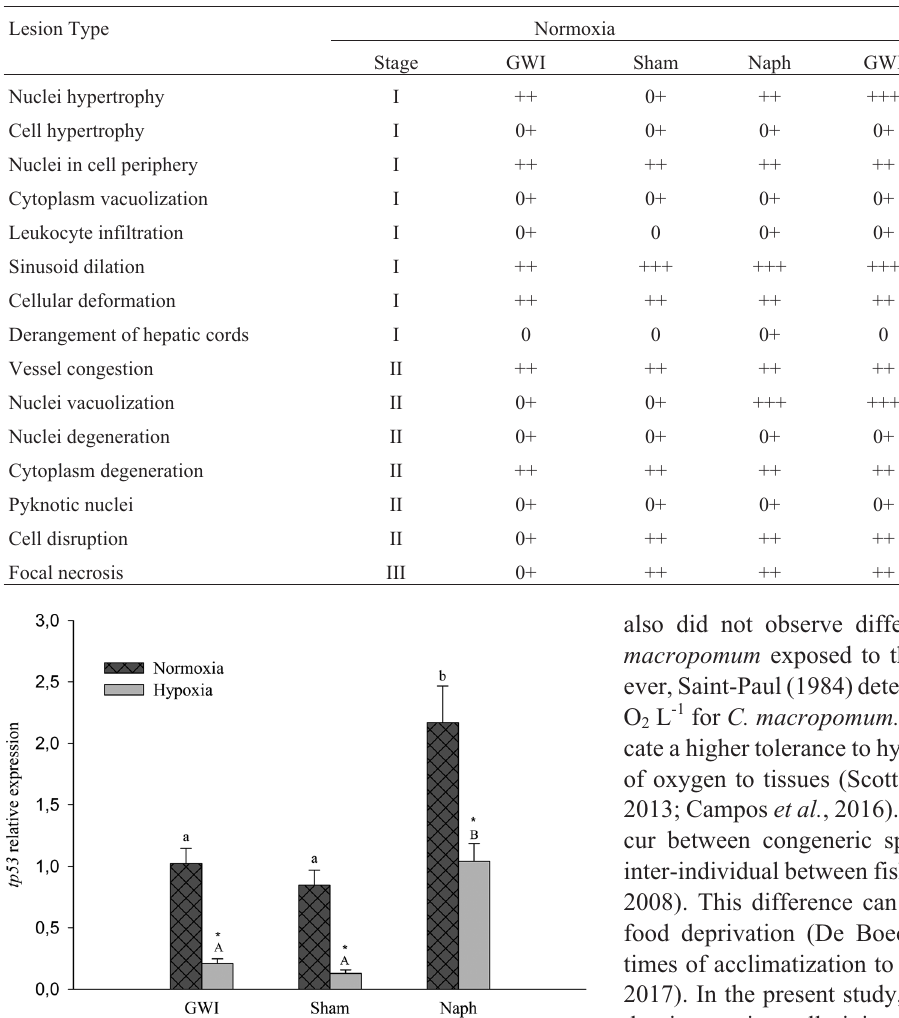
Table 2 - Qualitative distribution of histopathological damage and occurrence intensity (0 absent, 0+ rarely present, + low frequency, ++ frequent and +++ high frequency) on the liver of C. macropomum in the groups without injection (GWI), with corn oil injection (Sham) and naphthalene injection (Naph) after 96 h normoxia exposure followed by 6 h of hypoxia.